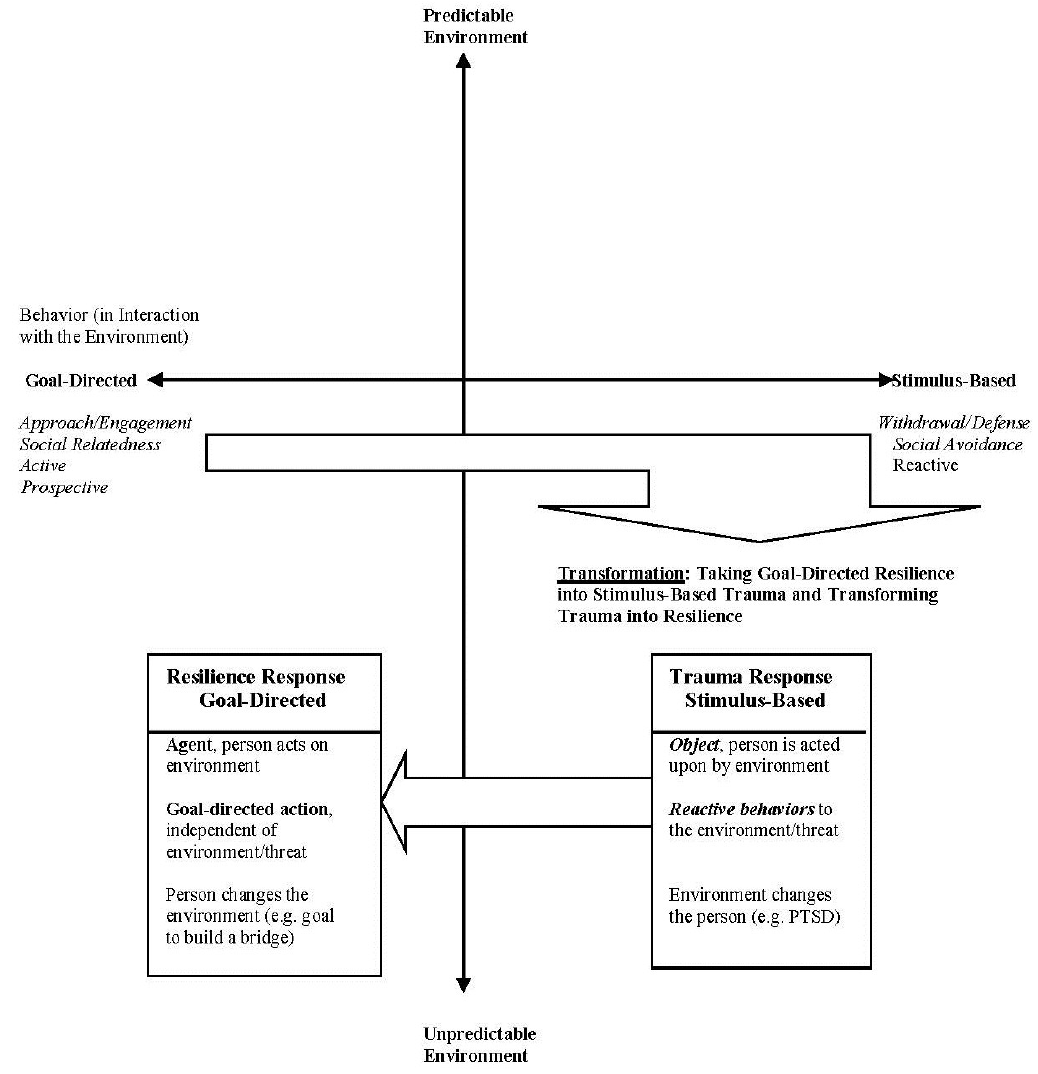
Figure 2. Schematic representation of goal-directed actions transforming stimulus-based responding. These two basic modes of interacting with the environment become visible in extreme situations where adaptive responses are goal-directed actions and trauma is expressed as stimulus based reaction. During resilience training, goal-directed actions are taken into past experiences of trauma, as indicated by the prominent forward arrow leading from the goal-directed pole to stimulus-based pole as experienced in trauma. The transformation is brought about by the qualities of goal-directed action: the person is an actor rather than reactor or object being acted upon by the environment, the action is independent of the environment, and the person changes how he/she experiences the environment or changes the environment itself. In this way, the person no longer is reactive to the environment, is no longer changed by the environment but is an agent, goal-directed in his/her actions, and affects changes related to the environment, as indicated by the reverse